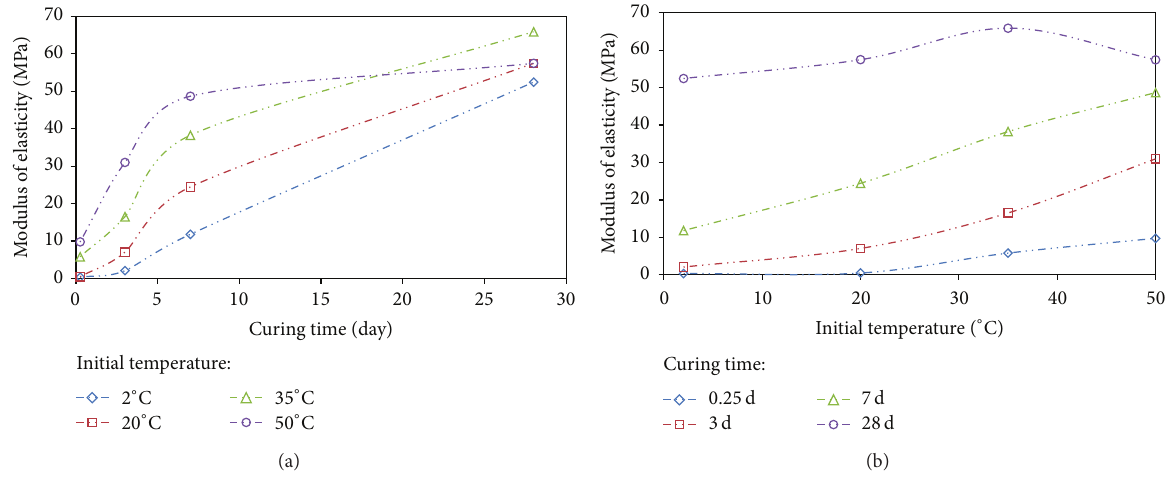
Figure 5: Effect of initial temperature and curing time on the evolution of CPB 𝐸 : (a) effect of curing time and (b) effect of initial